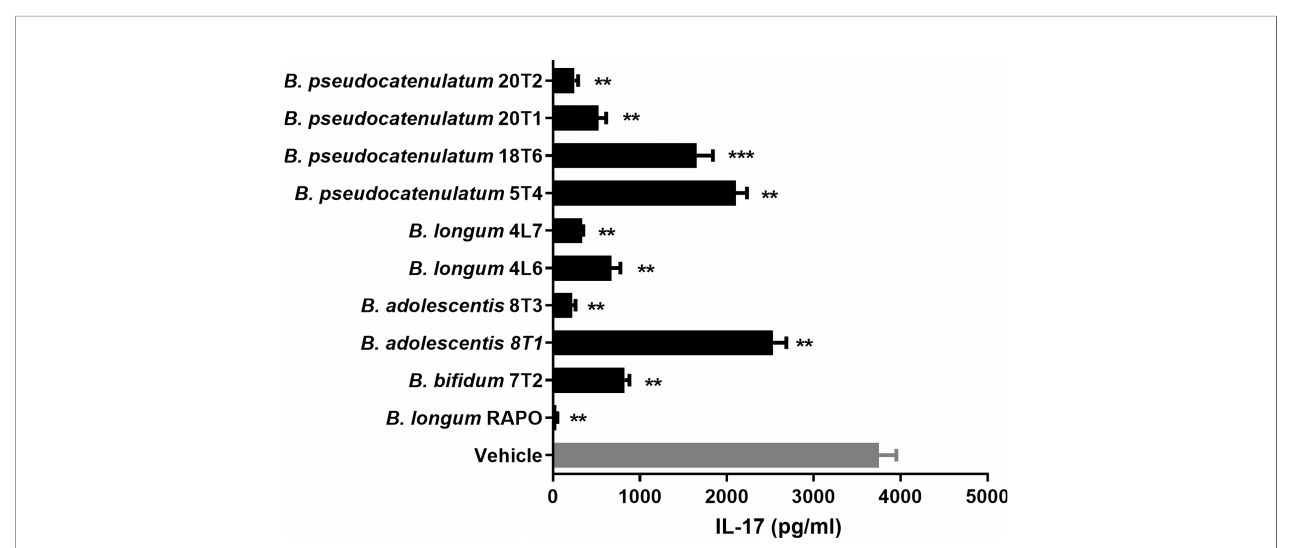
FIGURE 3 | Bi fi dobacterium longum RAPO suppresses IL-17 expression in human PBMCs. PBMCs were stimulated with anti-CD3 for 72 h. IL-17 levels in the culture supernatant were analyzed using ELISA. Data are presented as the means ± standard deviations (SDs) from three independent experiments. ** p < 0.03; *** p <